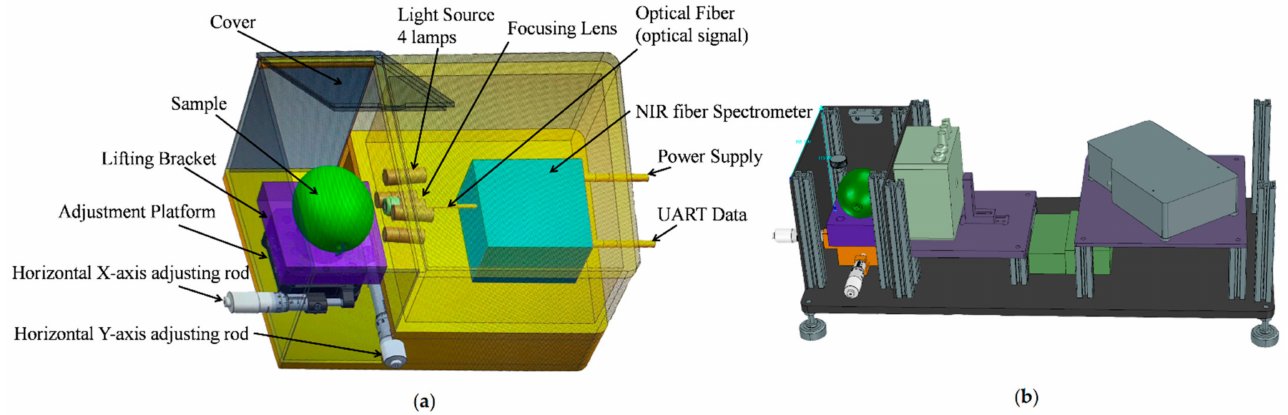
Figure 2. The near-infrared (NIR) spectroscopy system for spectral measurement. ( a ) Structure diagram of detector. ( b ) Design drawing of detector.